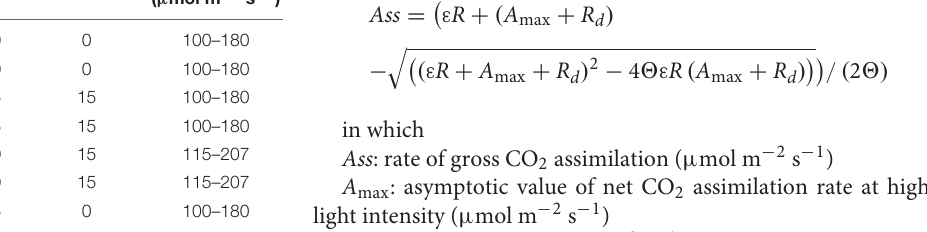
TABLE 1 | Spectral compositions of the light treatments. Treatment Blue (%) Green (%) Red (%) Far-red